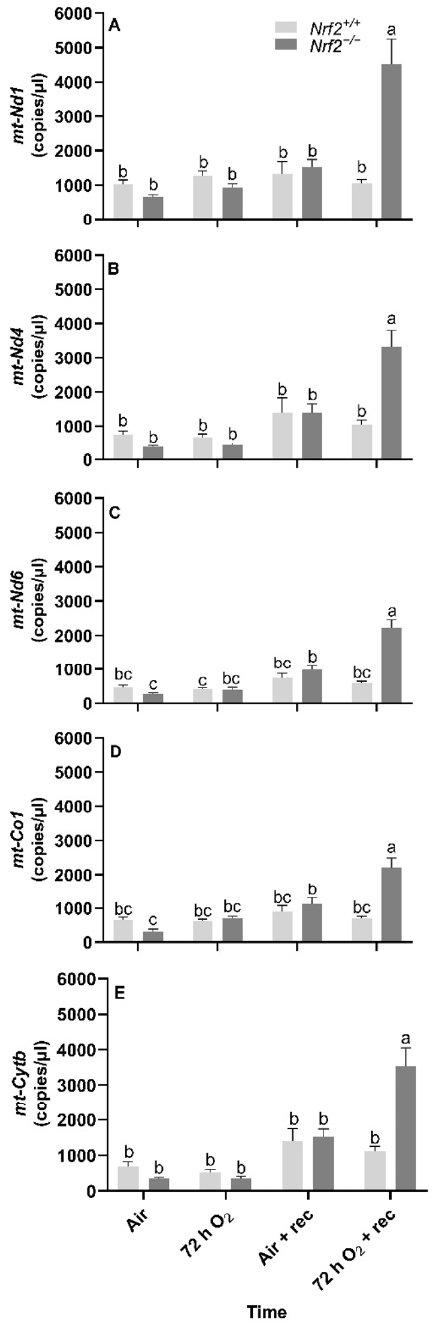
Figure 4. Effect of Nrf2 deletion on lung mitochondria-encoded mitochondrial gene expression in mice exposed to neonatal hyperoxia. Mitochondria-encoded mitochondrial genes, NADH dehydrogenase 1 ( mt-Nd1 ) ( A ), mt-Nd4 ( B ), mt-Nd6 ( C ), cytochrome c oxidase subunit 1 ( mt-Co1 ) ( D ), and cytochrome B ( mt-Cytb ) ( E ), were determined by digital droplet PCR in lungs of wild-type ( Nrf2 +/+ ) and Nrf2 - deficient ( Nrf2 − / − ) mouse neonates exposed neonatally to 72 h room air (air) or 72 h hyperoxia (>95% O 2 ,72 h O 2 ) from postnatal day (PND) 1 to 4 and the neonatal air- or O 2 -exposed mice recovered in room air for 5 weeks (air + 5 week rec, 72 h O2 + rec). Mean ± S.E.M. presented ( n = 3–5/group). A two-way ANOVA was employed with genotype ( Nrf2 +/+ , Nrf2 − / − ) and exposure (air, 72 h O 2 , air + rec, 72 h O 2 + rec) as the factors. Letters were used when there were significant main effects ( p < 0.05). Bars not connected by the same letter are significantly different ( p <